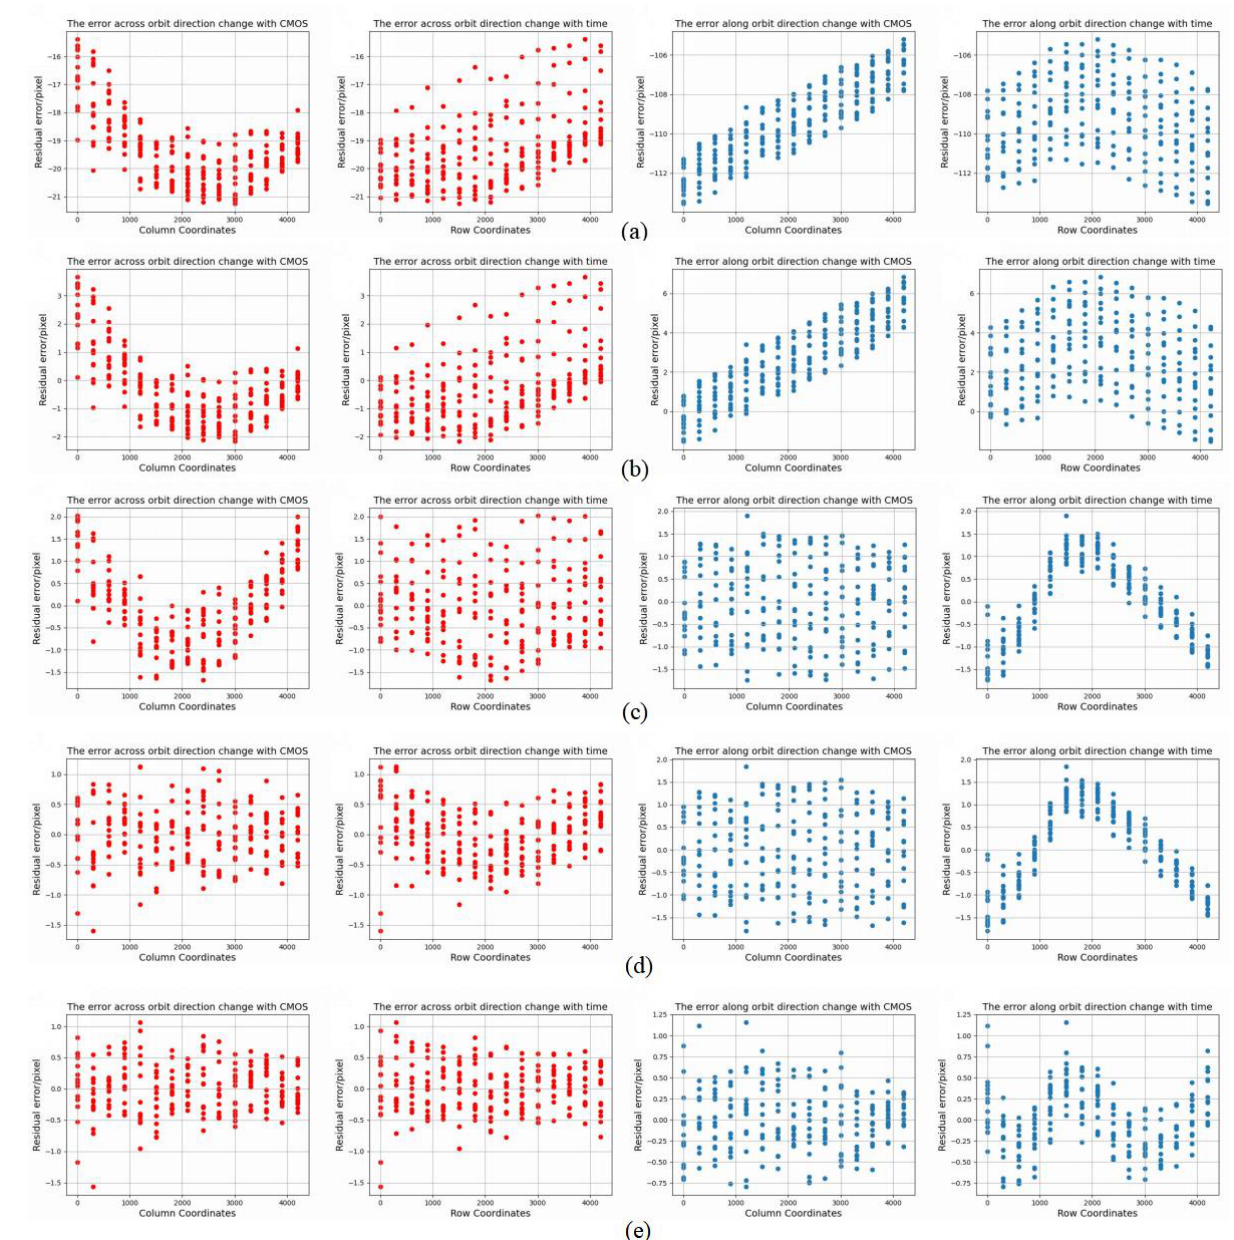
Figure 6. The 0517-Weihai-50 image geometric error of different methods changes with time and CMOS probe: ( a ) no compensation, ( b ) offset compensation, ( c ) affine transform compensation, ( d ) object–space bias compensation, ( e ) the model in this paper. (Red indicates across orbit direction, blue indicates along orbit direction).